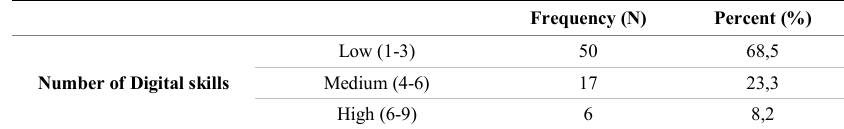
Table 23. Digital Skills for a Leader.